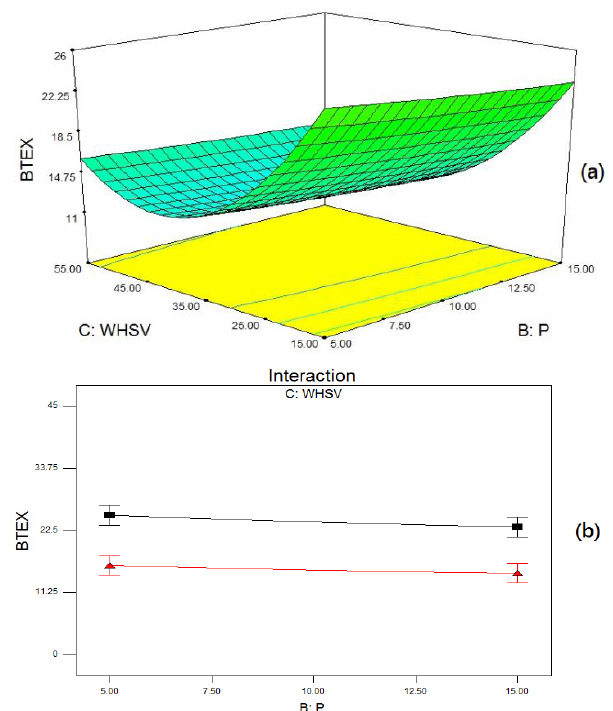
Figure 6. Interaction effect study between (B) pressure and (C) WHSV, under BETX (mol%) production. ( a ) 3D surface plot and ( b ) interaction plot.